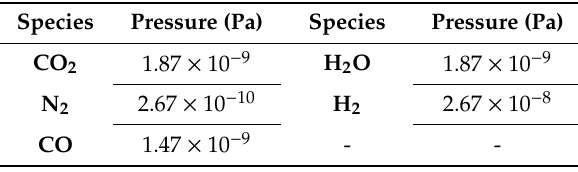
Table 6. The total pressure of all noble gas isotopes is equilibrated at 1.49 × 10 Table 5. Equilibrated partial pressures of residual background gases.